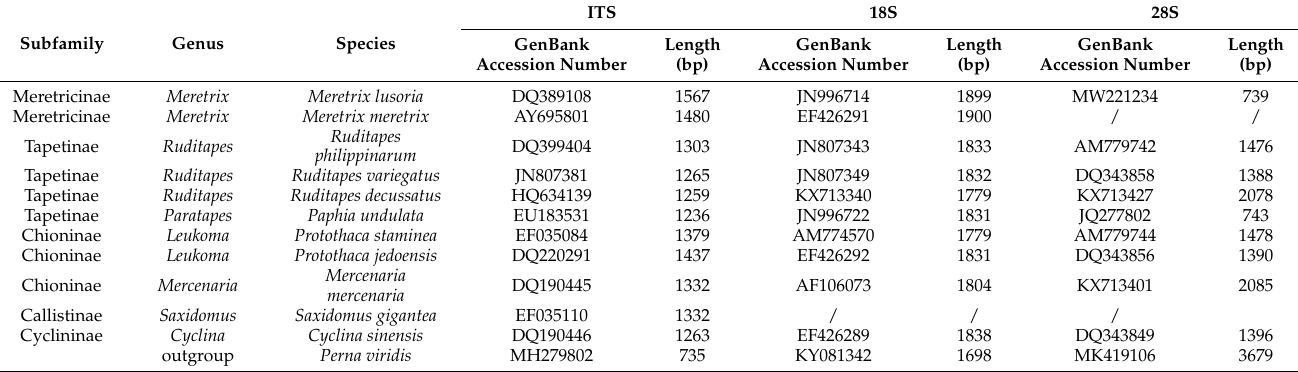
Table 1. Collection information, GenBank accession numbers and the lengths of each ribosomal region for Veneridae species used in the present